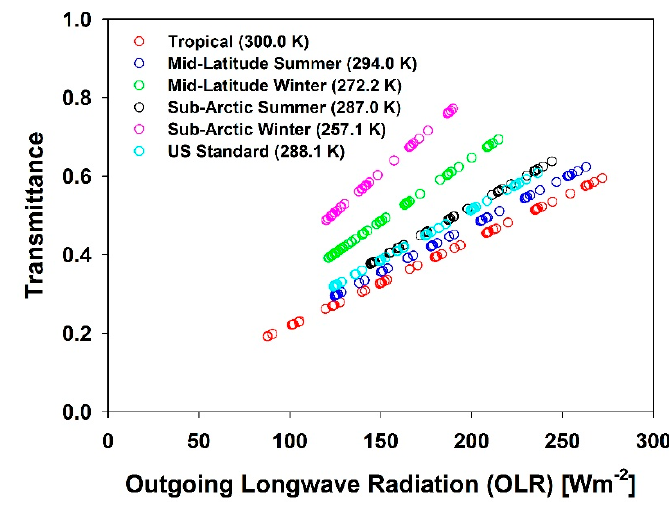
Figure 3. Scatter plot of infrared atmospheric transmittance according to surface temperature and OLR.